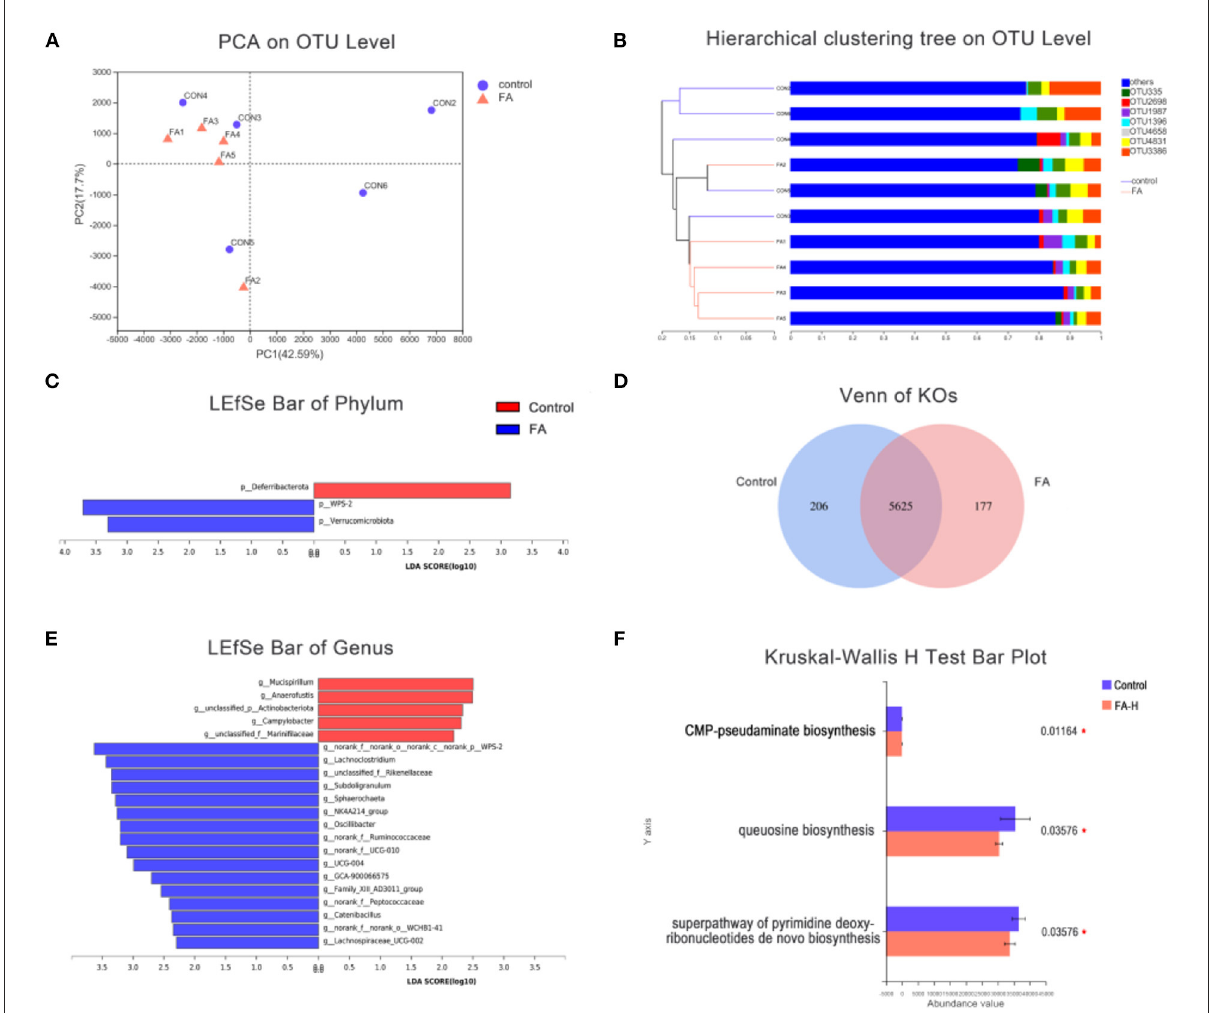
FIGURE3 Effect of FA on gut microbiota. (A) PCA of gut microbiota communities based on OUT level. (B) Hierarchical sample clustering tree of the microbial community at OUT level based on Bray–Curtis distances. (C) Comparison of gut microbial variations at phylum level between control and FA-H group using LEfSe analysis. (D) Venn diagram indicated unique and shared KOs. (E) Comparison of gut microbial variations at genus level between control and FA-H group using LEfSe analysis. (F) Significantly enriched MetaCyc pathways of gut microbiota between the control and FA-H groups. * P <